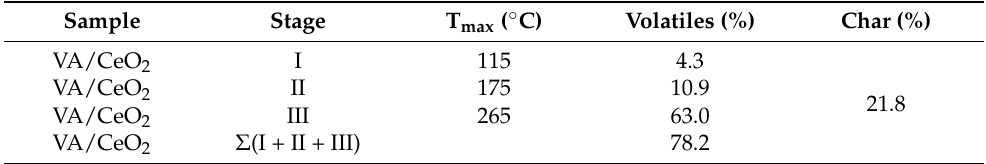
Table 7. Pyrolysis yields for TGA pyrolysis of VA/CeO 2 (0.6 mmol/g).